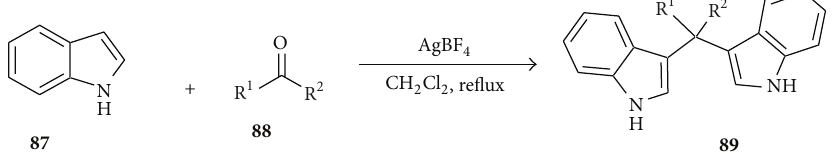
Scheme 17: Synthesis of 3-substituted indole derivatives.